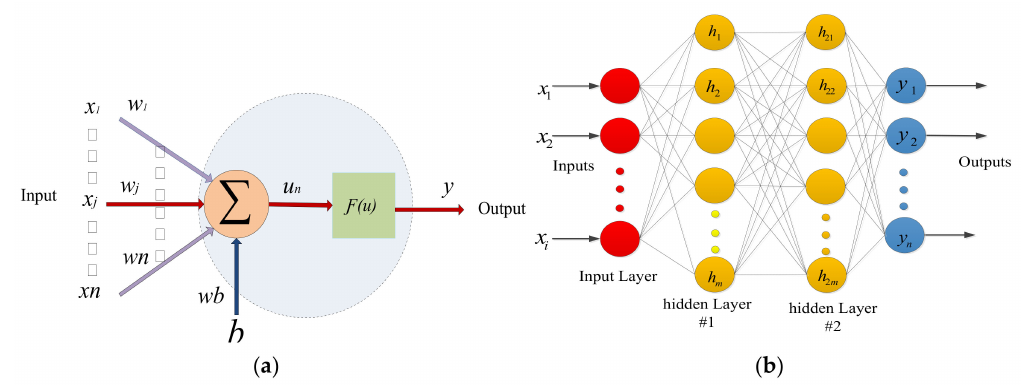
Figure 1. ( a ) Schematic of a generic feed-forward network and ( b ) a typical MLP structure with neuron